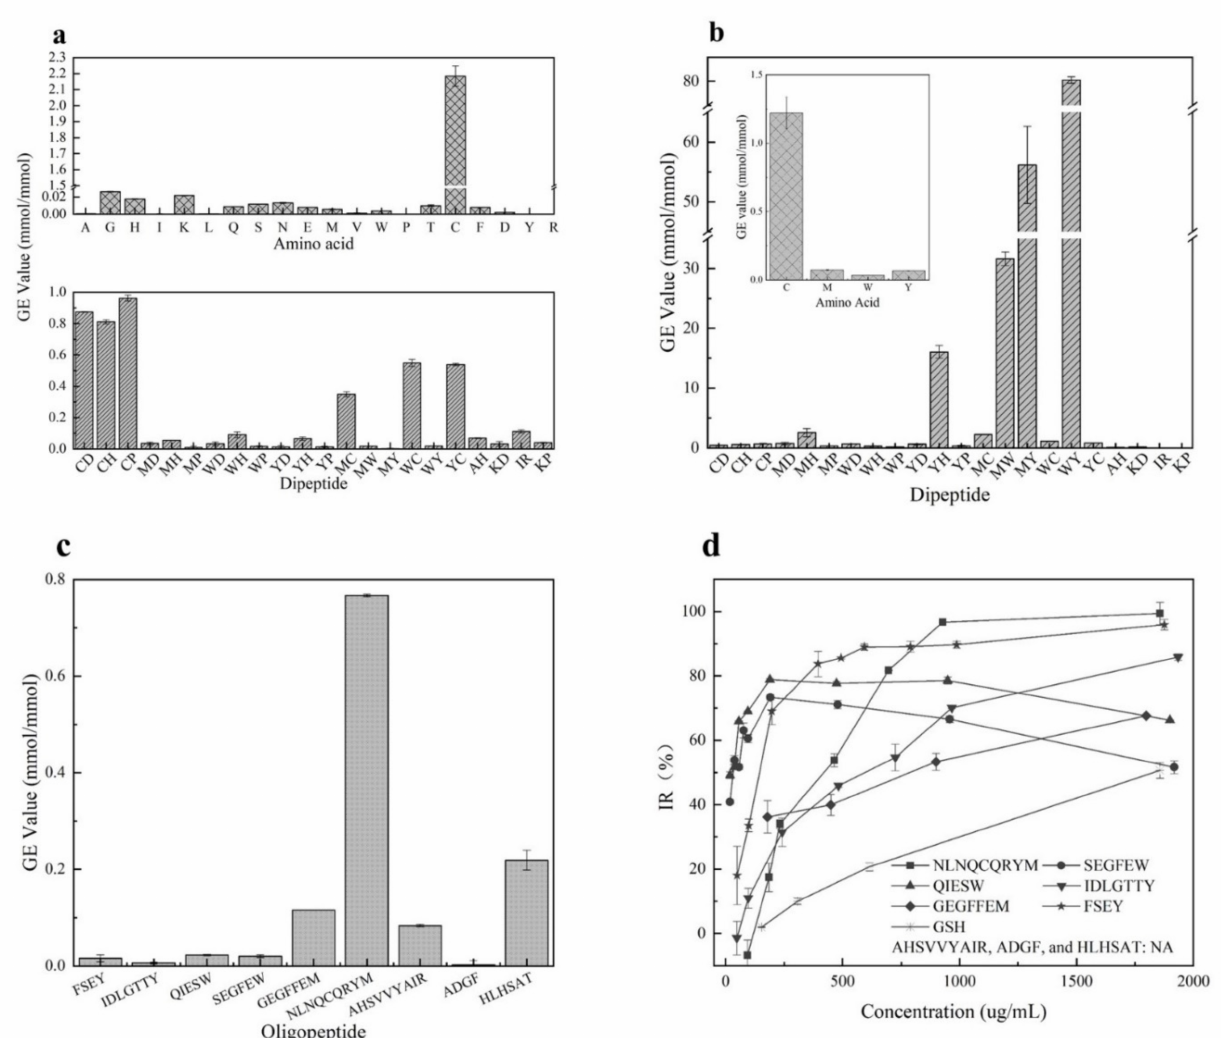
Figure 1. Antioxidant activities of amino acids and peptides. ( a ) means activity of amino acids